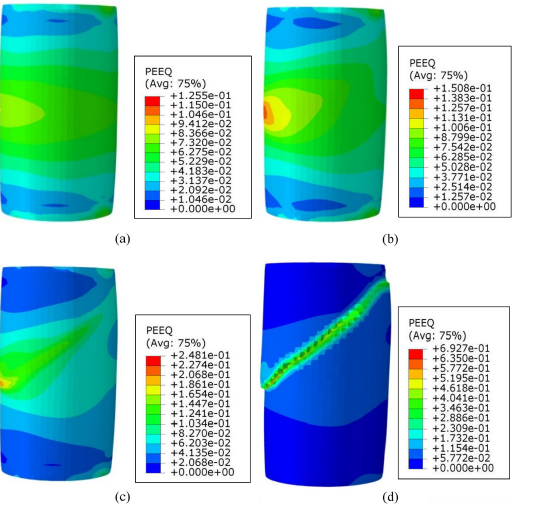
Figure 4. The equivalent strain maps of 1mm sample in the deformation and fracture process at different strains, a) 11.62%, b) 12.25%, c) 12.53% and d) 12.6%.